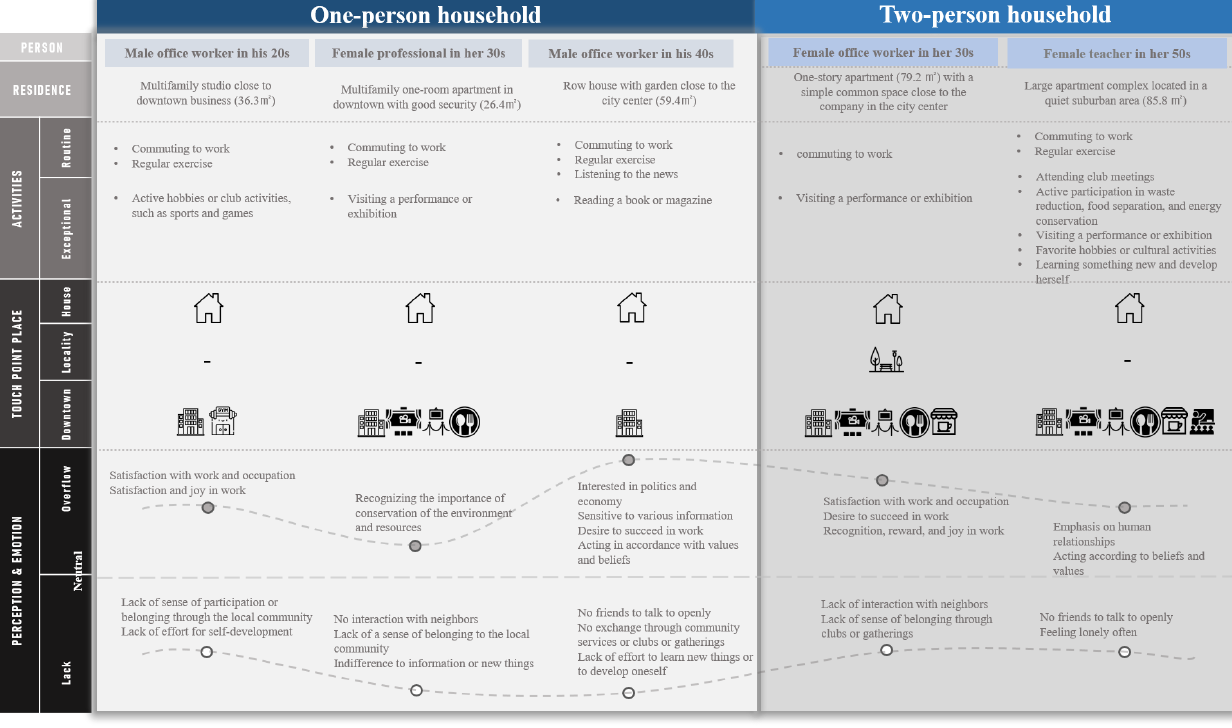
Figure 3. User Experience Mapping Between One-person and Two-person Households.